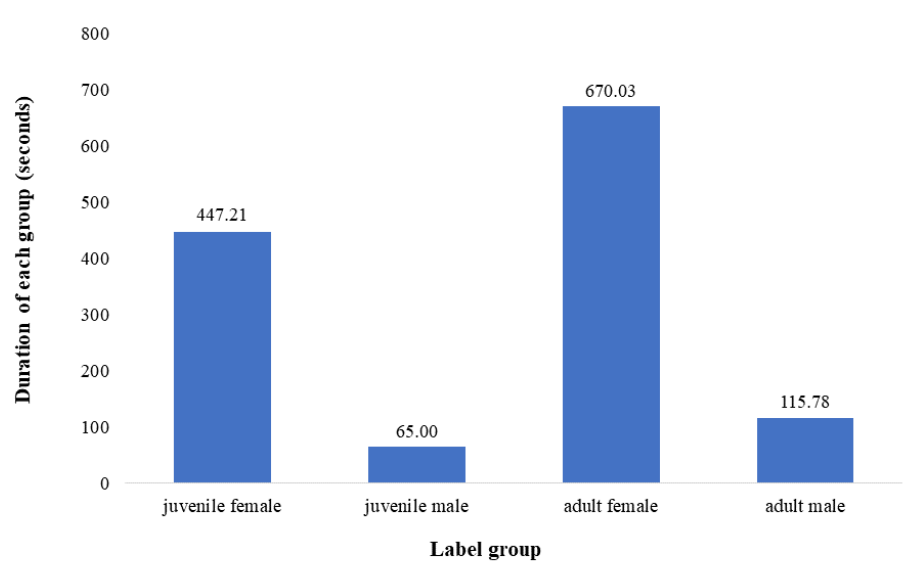
Figure 1. The total duration of call recordings from each grouping of pandas in this study: juvenile female, juvenile male, adult female, and adult male.